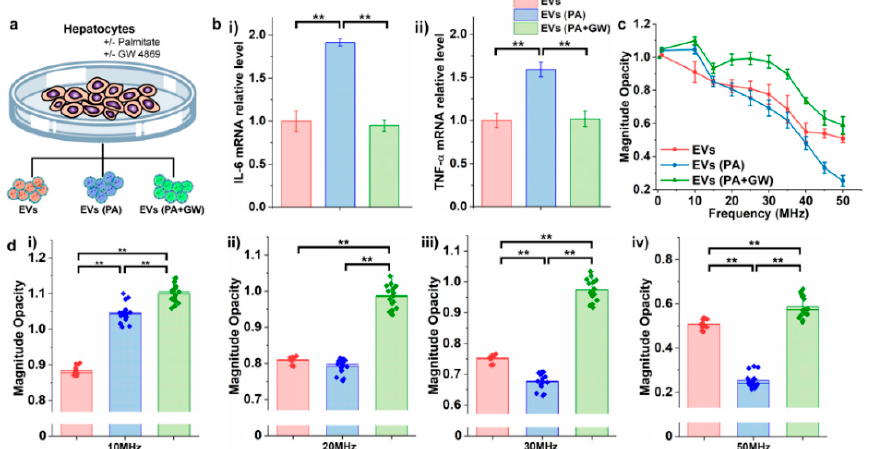
Figure 5. ( a ) Isolation of EVs from human hepatocellular carcinoma cell lines under normal culture medium, the PA-treated condition, and the mixture of PA- and GW4869-treated conditions. ( b ) Mouse bone marrow-derived macrophages (BMDMs) were cultured with EVs for mRNA expression analysis by the quantitative polymerase chain reaction of ( i ) IL-6 mRNA and ( ii ) TNF- α mRNA. ( c ) Magnitude opacity spectrum of EVs derived from human hepatocellular carcinoma cell lines under three culture conditions. ( d ) Box plots of magnitude opacity comparison of EVs at three culture conditions at 10–50 MHz. (** p < 0.05, n =